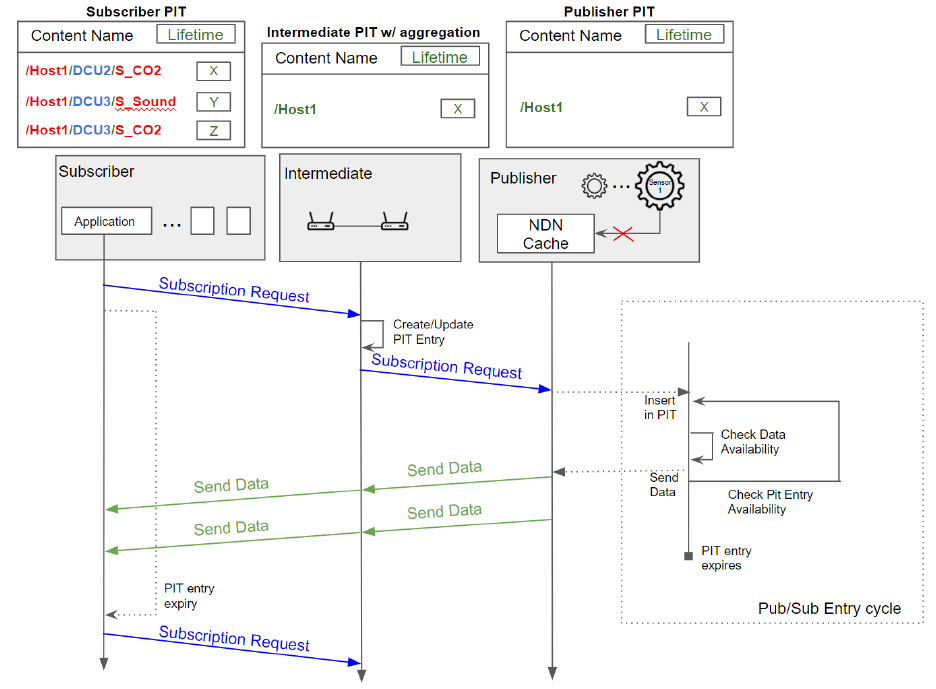
Figure 5. ndnIoT-FC pub-sub